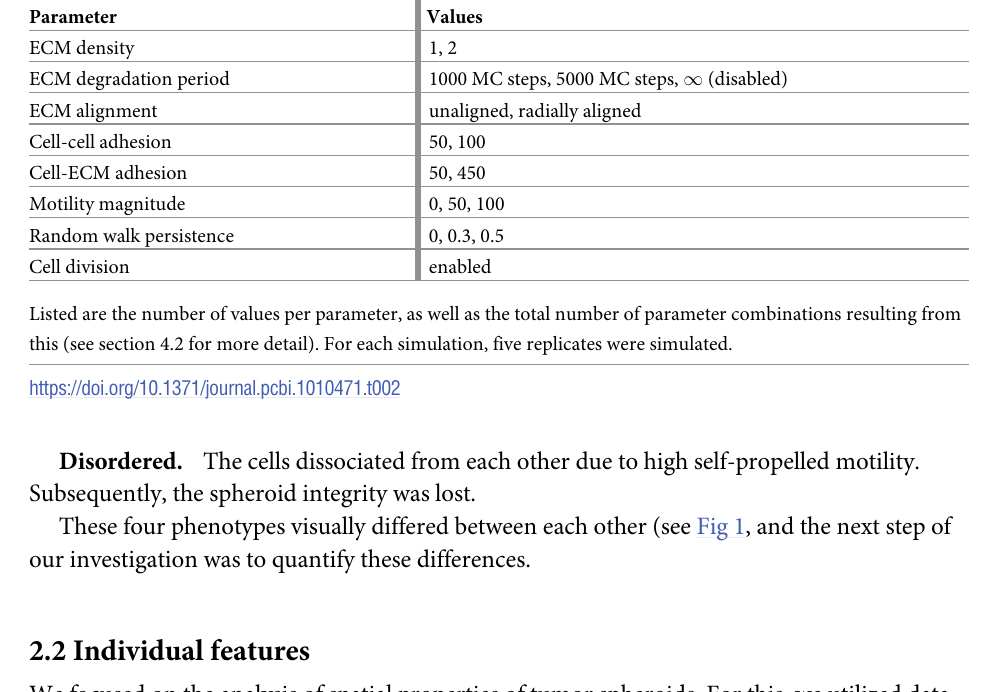
Table 2. Simulated parameter space from which the four phenotypes were obtained.